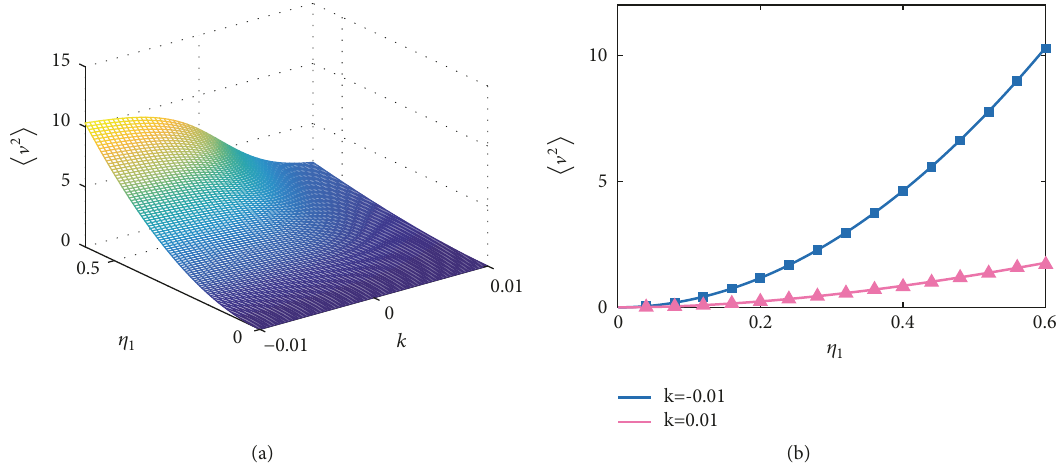
Figure 13: The dependence of the mean square electric voltage ⟨ V 2 ⟩ on 𝑘 and 𝜂 1 . Solid lines are the analytical results; symbols result from numerical